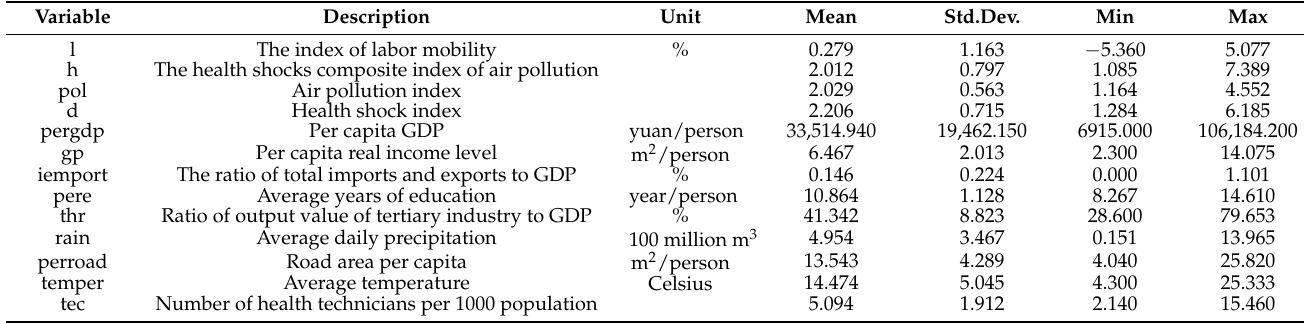
Table 1. The descriptive statistics of the